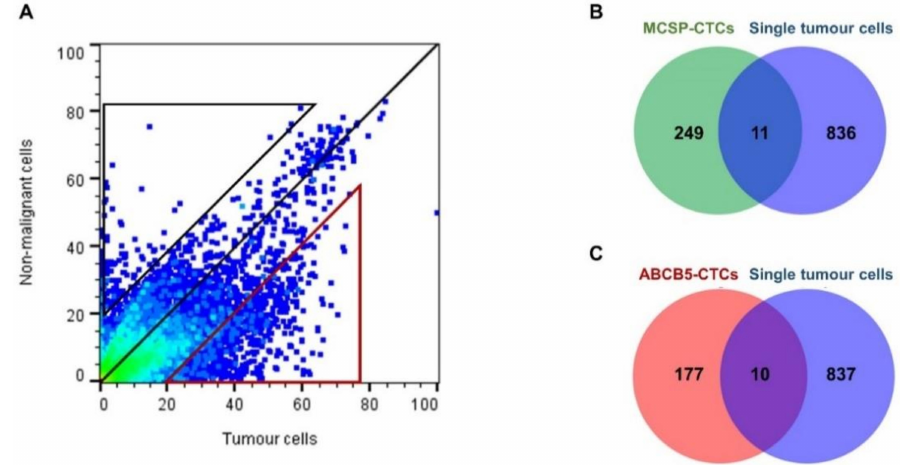
Figure 4. Identification of genes specific to single melanoma tumour cells that are also up-regulated in MCSP- and ABCB5-enriched CTC fractions. ( A ) Pivot plot comparing gene expression profiles of single tumour cells and nonmalignant cells, from publicly available data [31], identified 847 genes that are specifically expressed by single tumour cells (red triangle) and 196 genes specifically expressed by single nonmalignant cells (black triangle). Comparison of these tumour-specific genes against the genes found to be up-regulated in MCSP ( B ) and ABCB5 CTC fractions ( C ) identified, respectively, 11 and 10 genes that are commonly expressed by single melanoma tumours as well as by MCSP or ABCB5 CTC